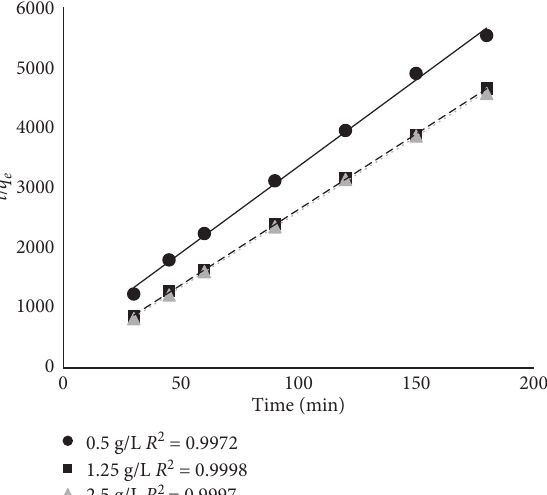
Figure 6: Pseudo-second-order kinetics for the sorption of methylene blue (MB) onto Ginkgo biloba leaf (GBL) powder.